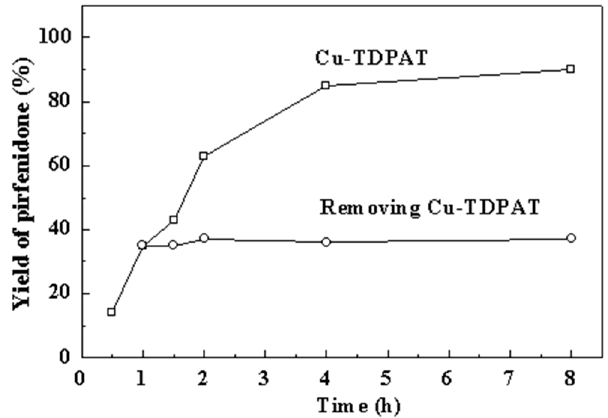
Figure 2. Yield as a function of reaction time in the coupling reaction of 5-methyl-2-(1 H )-pyridone and iodobenzene with Cu-TDPAT as catalyst at 120 °C. □ : catalyst present throughout; ○ : catalyst and iodobenzene with Cu-TDPAT as catalyst at 120 ˝ C. ˝ : catalyst removed from the suspension removed from the suspension after 1 h. Reaction conditions: PhI (1 mmol), pyridone (1 mmol), Cu-TDPAT (0.05 mmol, based on copper), K 2 CO 3 (2 mmol), DMSO (5 mL).